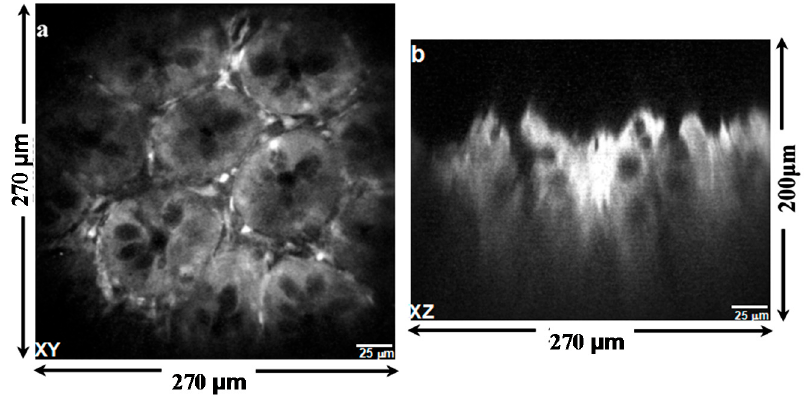
Figure 10. Multi-photon excited fluorescence images of mouse colonic epithelium that constitutively expresses tdTomato ex vivo reveal crypt structure. ( a ) The image in horizontal (XY) plane was collected using the biaxial MEMS scanner only; ( b ) the image in vertical (XZ) plane collected by using both the lateral and axial MEMS scanners.